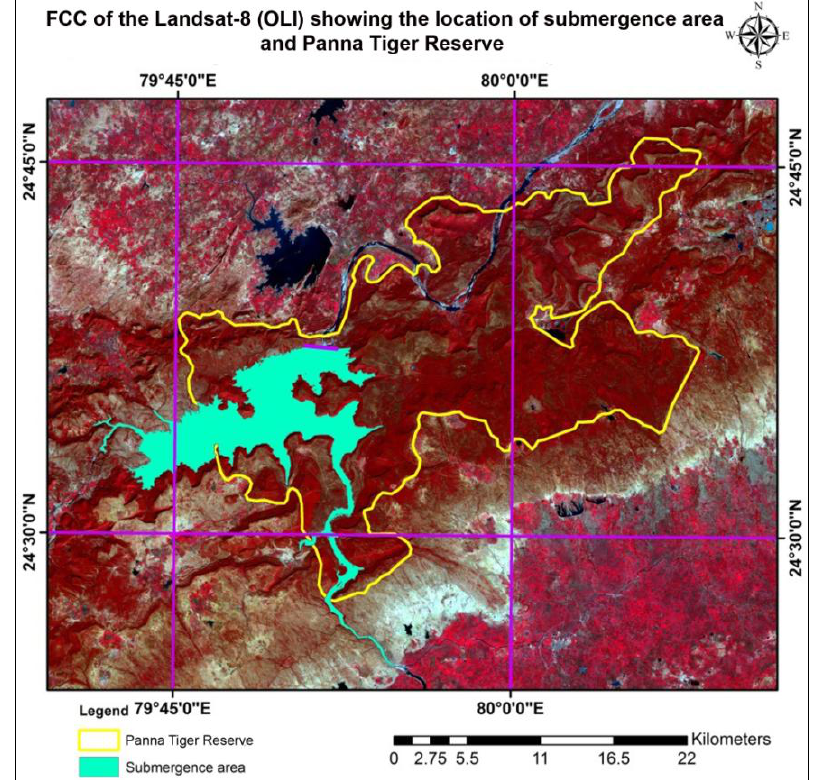
Fig. 1. Location of the study area: False color composite of Landsat